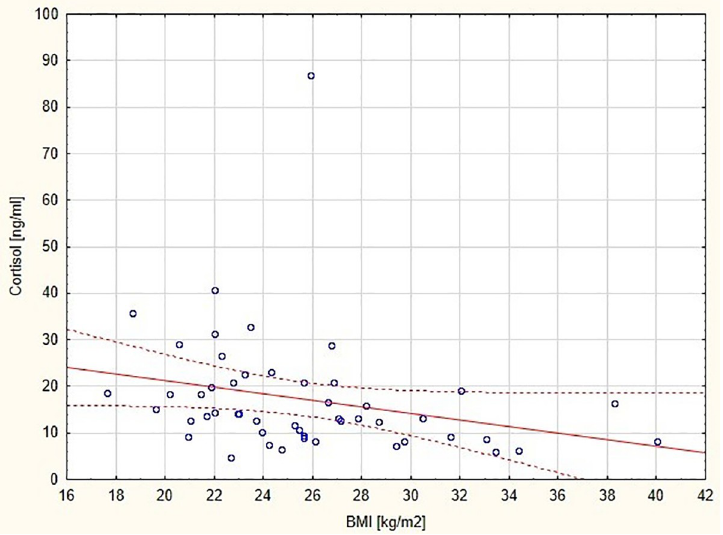
In the presented studies, in breast milk samples from women giving birth before 37 weeks of pregnancy DPPH inhibition was shown at 65.46%, while the total antioxidant status